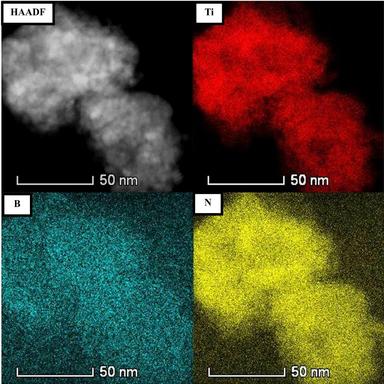
High-angle annular dark field image (HAADF) and Energy-Dispersive X-ray Spectroscopy (EDS) mapping for 300TiBCN.